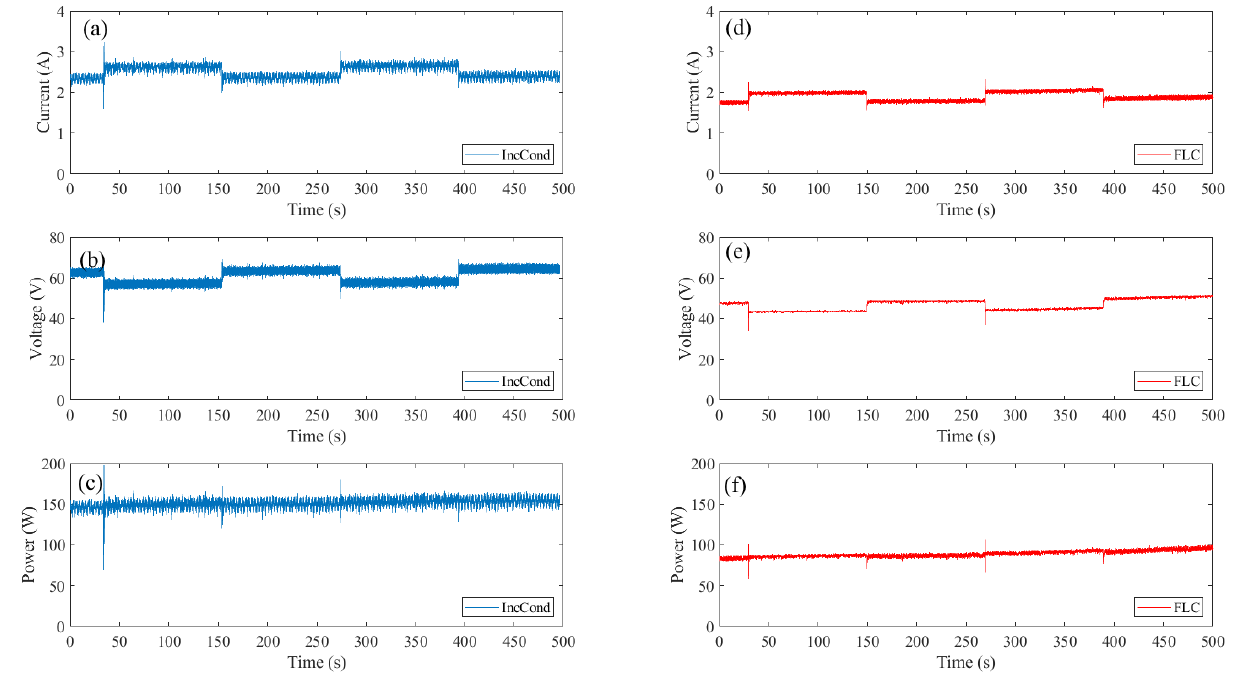
Figure 10. Boost converter output signals based on IncCond and FLC: ( a ) output current signal based on IncCond; ( b ) output voltage signal based on IncCond; ( c ) output power signal based on IncCond; ( d ) output current signal based on FLC; ( e ) output voltage signal based on FLC; and ( f ) output power signal based on